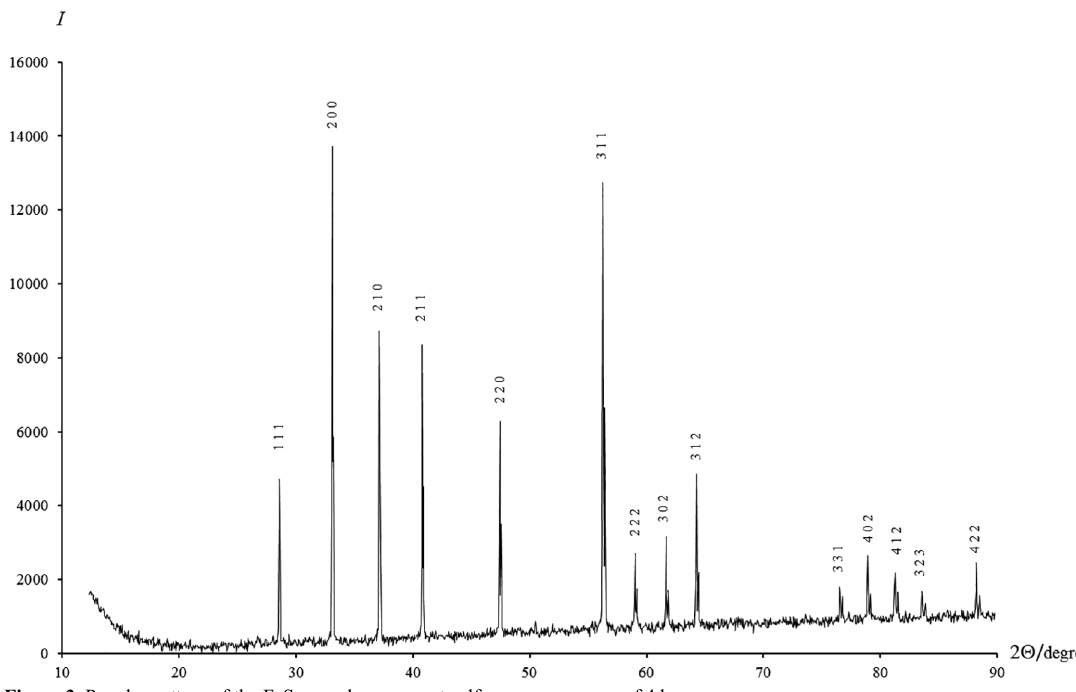
Figure 3. Powder pattern of the FeS